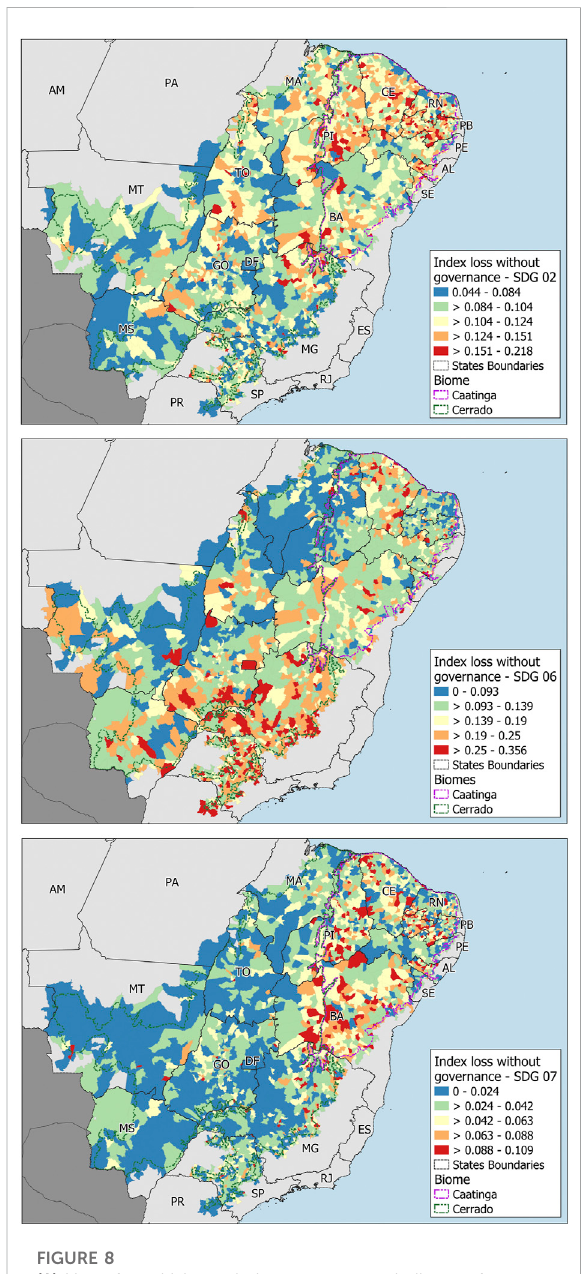
FIGURE 8 (A) Map of sensitivity analysis to governance indicators for SDG 2, (B) map of sensitivity analysis to governance indicators for SDG 6, and (C) map of sensitivity analysis to governance indicators for SDG